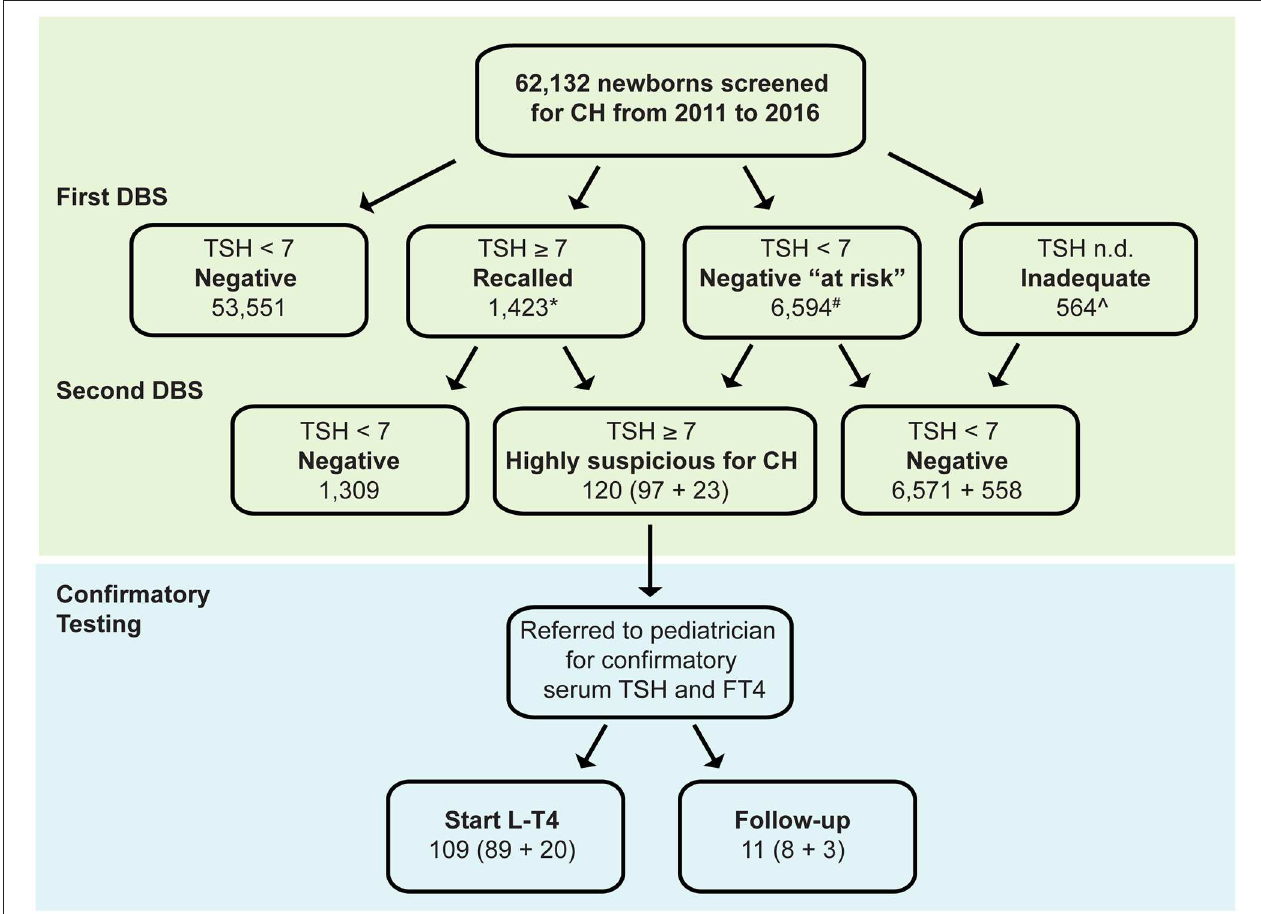
FIGURE 1 | Distribution of TSH results at the initial (first dried blood spot, DBS) and subsequent testing in 62,132 babies born in Abruzzo (Italy) between January 1, 2011 and December 31, 2016. DBS, dried blood spot, *17 lost to follow-up, ∧ 6 lost to follow-up, # Neonates belonging to the following categories: preterm, low birthweight, twins, malformations, blood transfusions, dopamine, total parenteral nutrition, maternal thyroid disease CH Congenital hypothyroidism, L-T4 Levothyroxine.